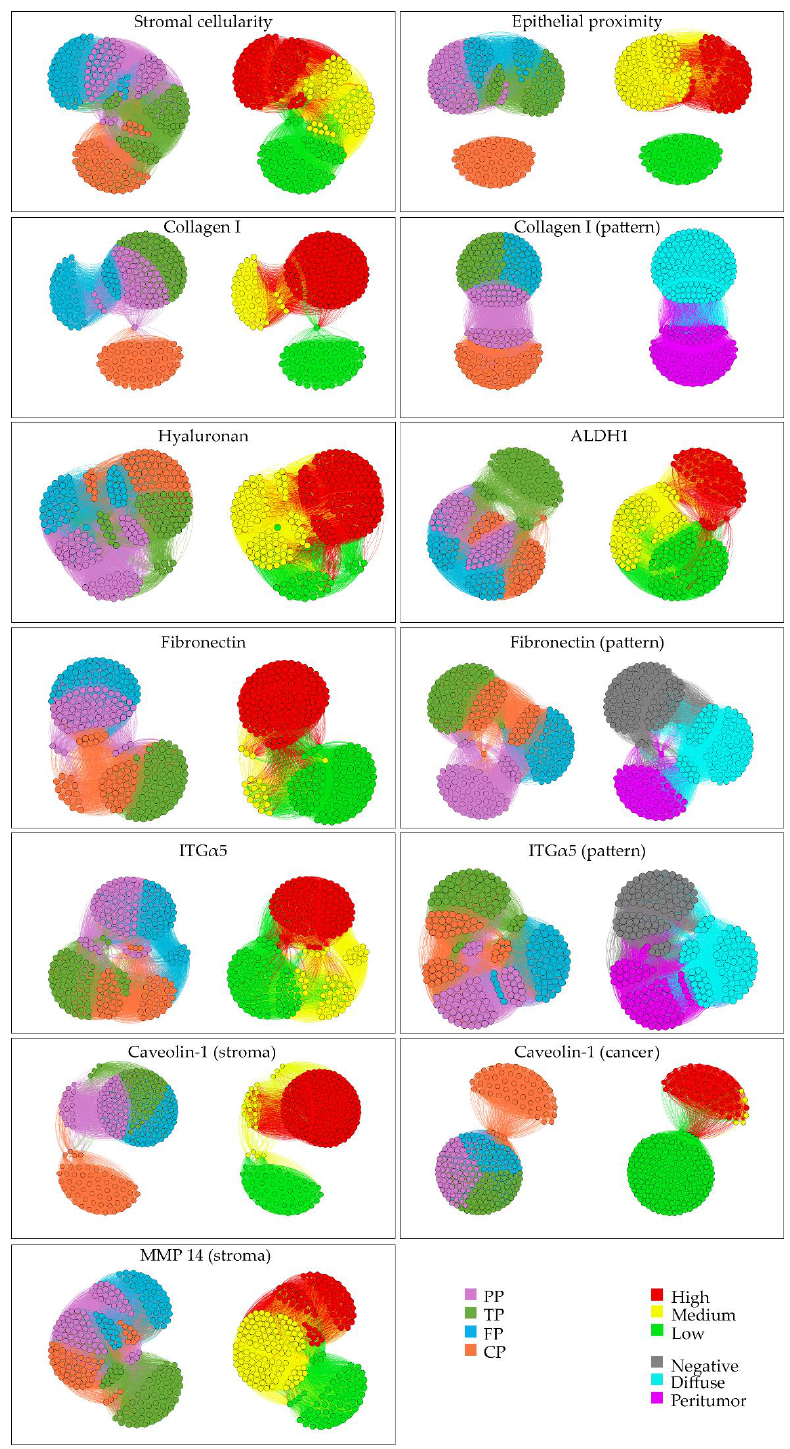
Figure 4. Complex network visualization of cancer-cell-related and stromal features in the four tumor patterns. For a particular feature, paired Gephi-generated networks visualize the four morphological patterns (left) and the results for that feature (right). Every dot in the network represents a single ROI, and the length of the connecting lines represents the similarity between the connected nodes ( n = 233). Absence of connecting lines between dots (e.g., in Gephi for epithelial proximity) indicates the lack of similarity. For each feature, the p -value reflecting the difference between the patterns is stated in Table